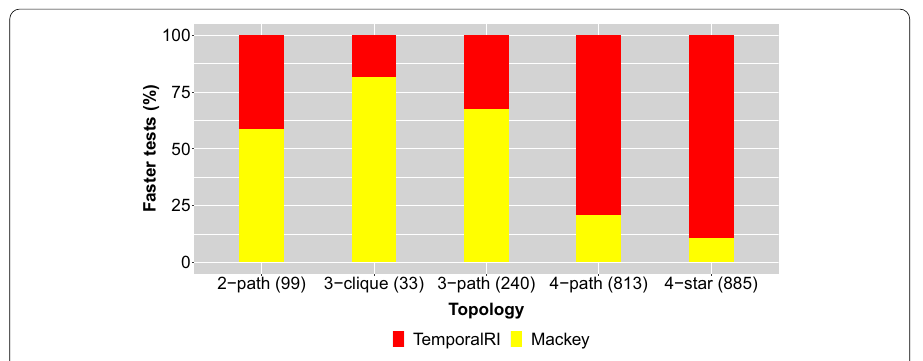
Fig. 8 Percentage of tests on queries with k = 3 edges in which TemporalRI or Mackey’s algorithm is the fastest. Results are clustered by subgraph topology. Number of tests in each cluster are indicated in parentheses. Experiments completed neither by TemporalRI nor by Mackey’s algorithm are excluded from the analysis